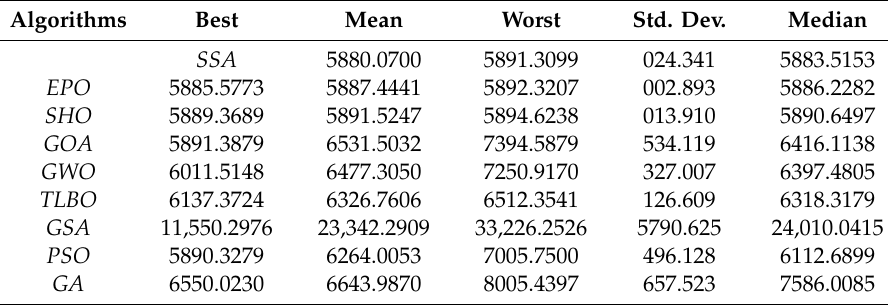
Table 6. Statistical results for pressure vessel design